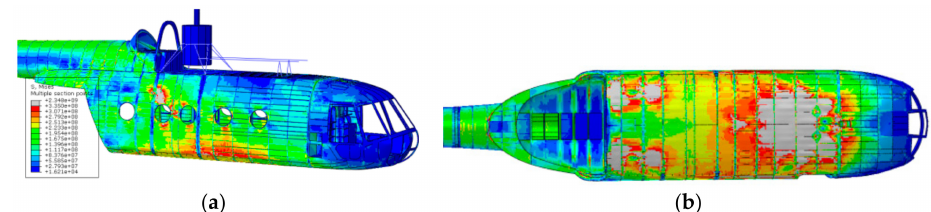
Figure 14. Equivalent Von Mises stress field for the 0.78 m drop. Perspective view ( a ), bottom view ( b ).